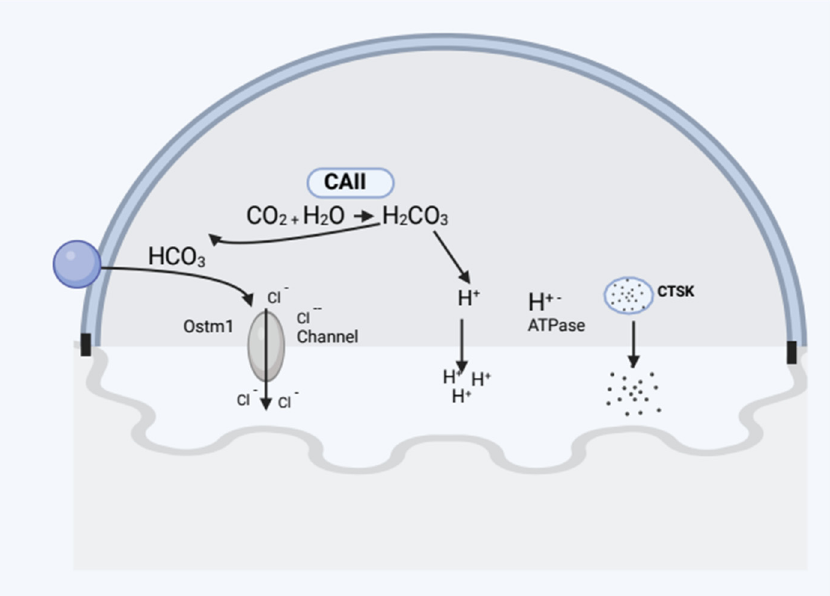
Figure 4. Illustrating the proteins involved in the pathophysiology of human osteopetrosis. Osteopetrosis with Autosomal